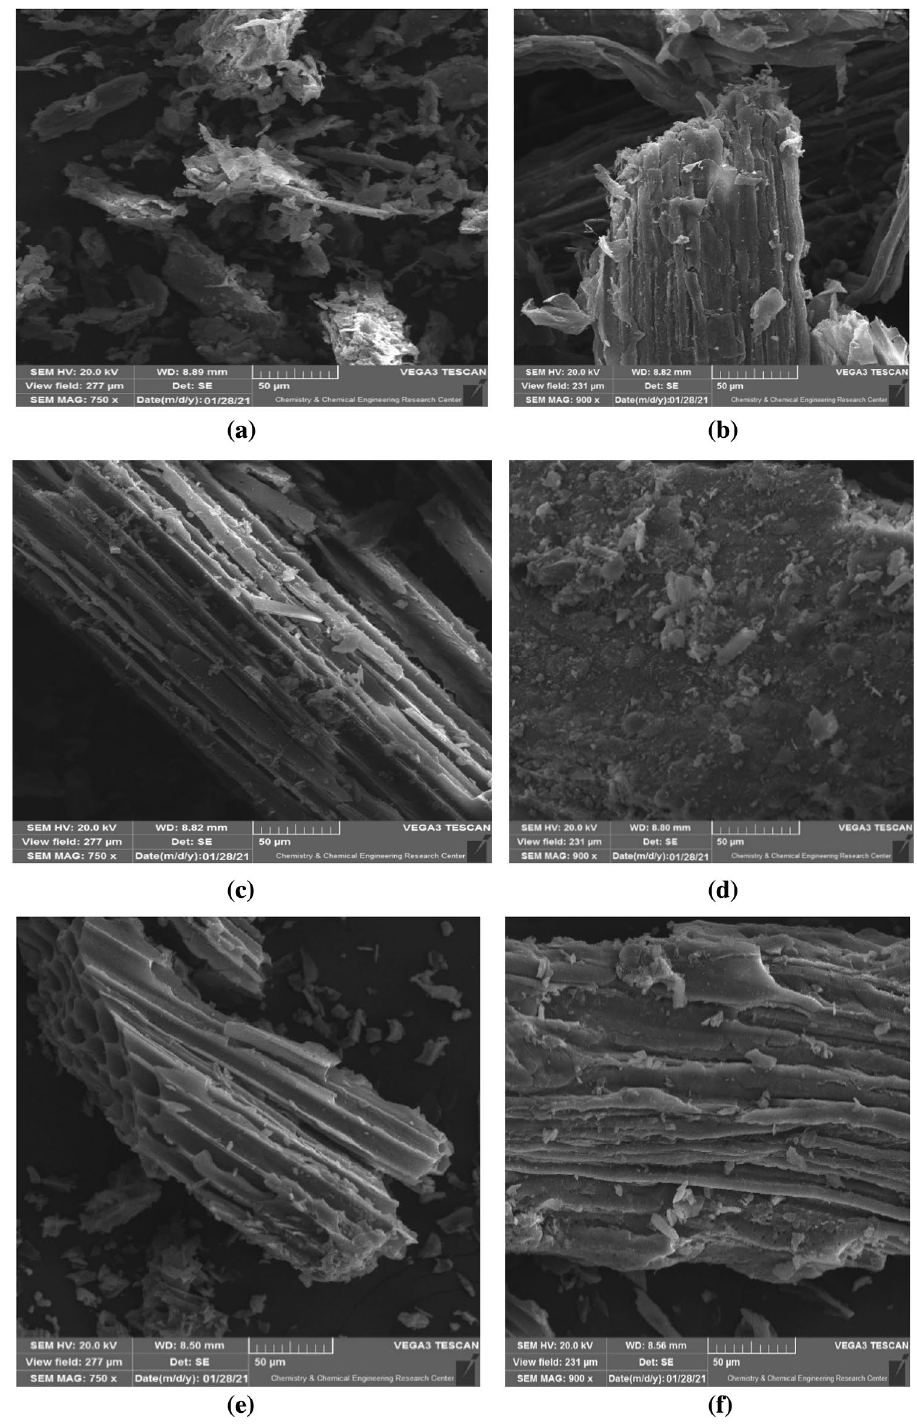
Figure 3. SEM images of ( a , b ) bagasse, ( c , d ), HCop, and AHCop ( e , f